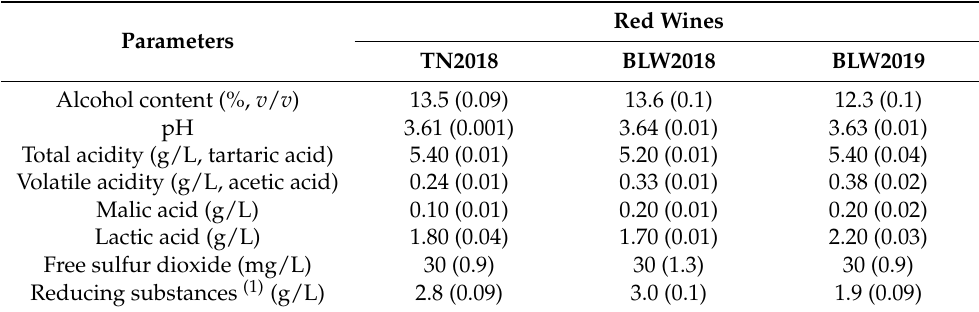
Table 1. The initial general physicochemical characteristics of the red wines that were used in the experimental